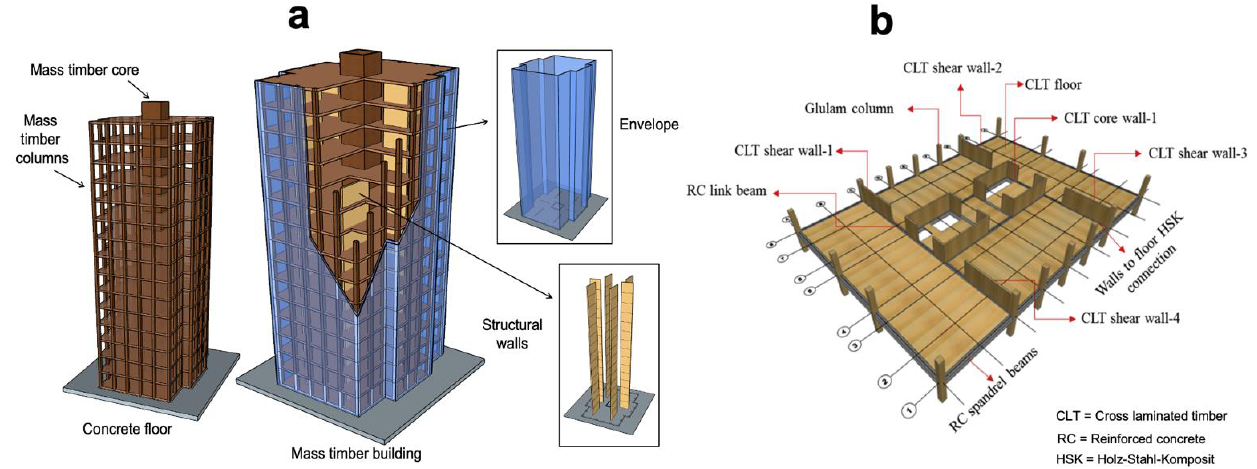
Figure 4. Mass timber building schematic illustration ( a ) and connections of the floor and columns ( b ) modified from [148].